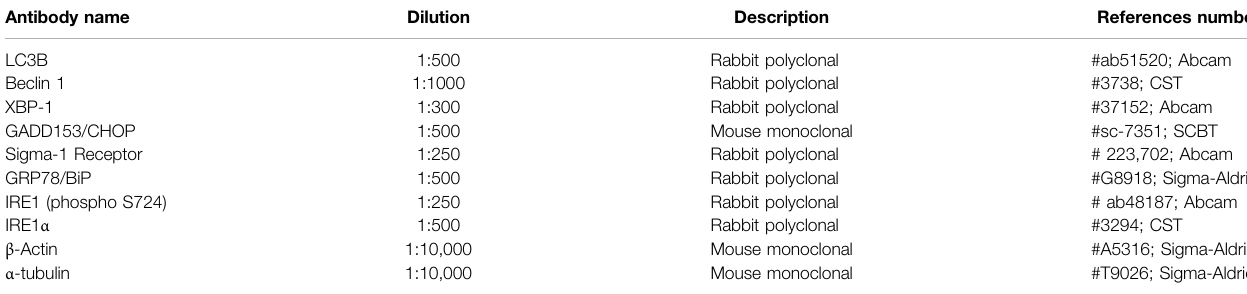
TABLE 1 | Primary antibodies used for WB